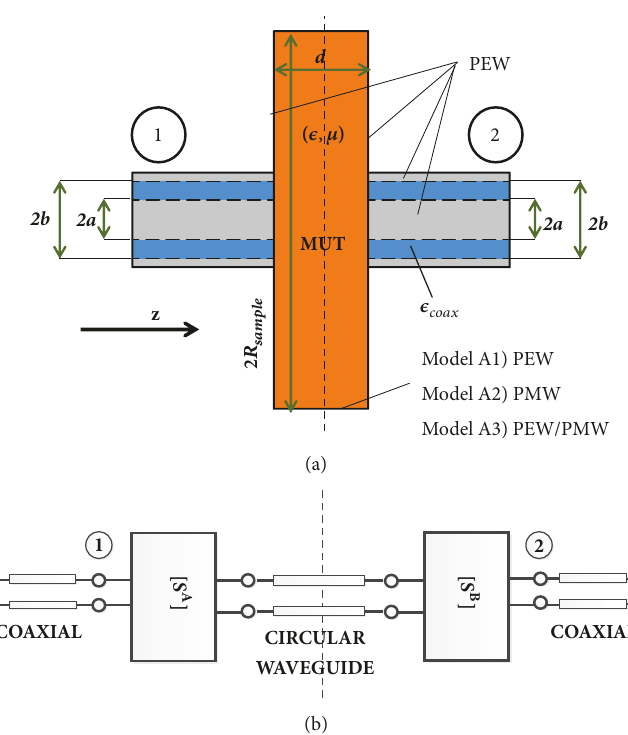
Figure 6: (a) Dimensions defining the model A (with revolution symmetry): case A1, PEW; case A2, PMW; case A3, combination of PEW and PMW; (b) Block diagram of the analysis by mode-matching, showing the symmetry plane.